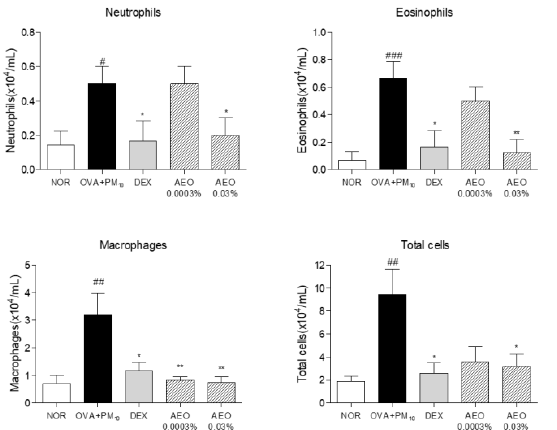
Figure 5. AEO attenuated neutrophils, eosinophils, macrophages, and total cells in NALF of OVA+PM 10 -induced allergic rhinitis mice. The number of cells in NALF was counted based on the morphological features of the cells. The data are presented as the means ± standard error of the mean. # p < 0.05, ## p < 0.01, ### p < 0.001 compared to NOR group. * p < 0.05, ** p < 0.01 compared